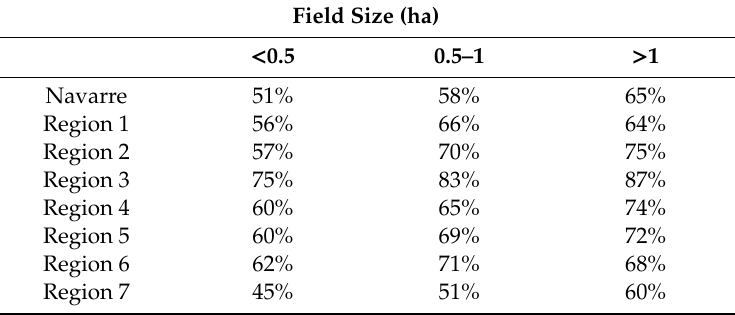
Table 8. Overall Accuracy for the stratified external validation dataset by field area of Ens scheme (using R 2 as the best fit